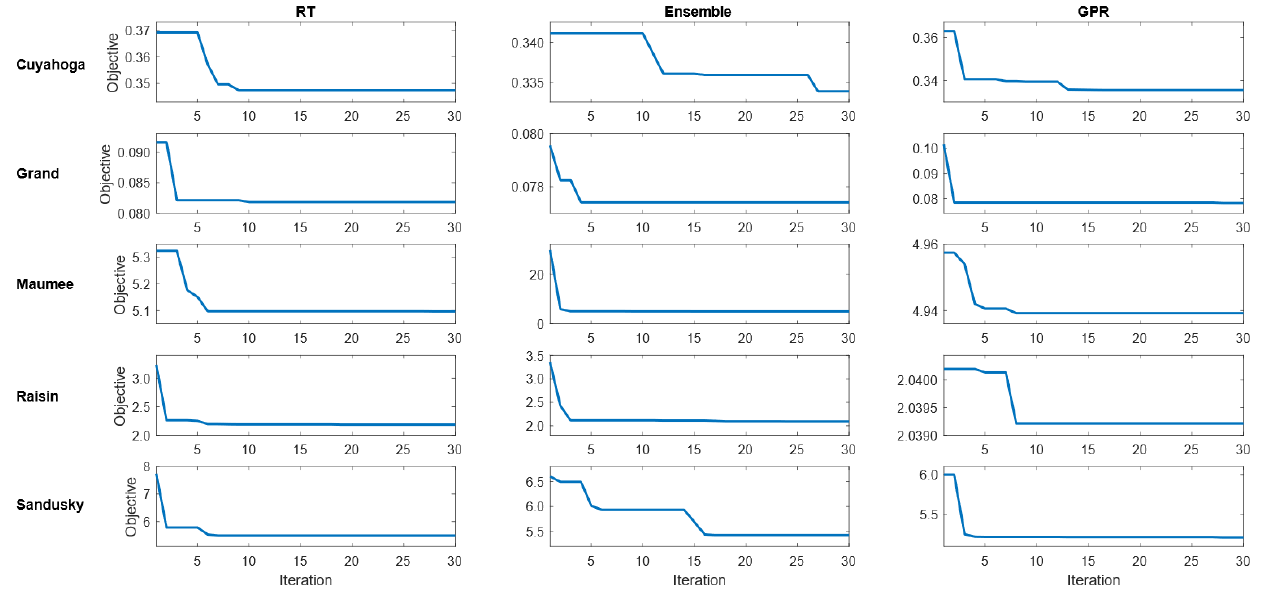
Figure 1. Objective in the iterative process of BO for nitrate prediction. Table 1. Result of Bayesian optimized hyperparameters in RT, ensemble, and GPR models for nitrate prediction.